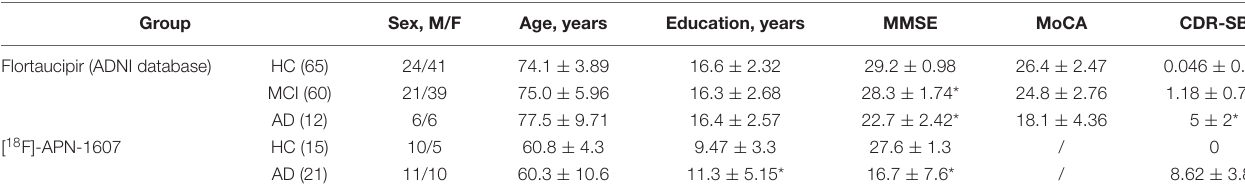
TABLE 1 | Clinical and demographic characteristics of the study subjects.